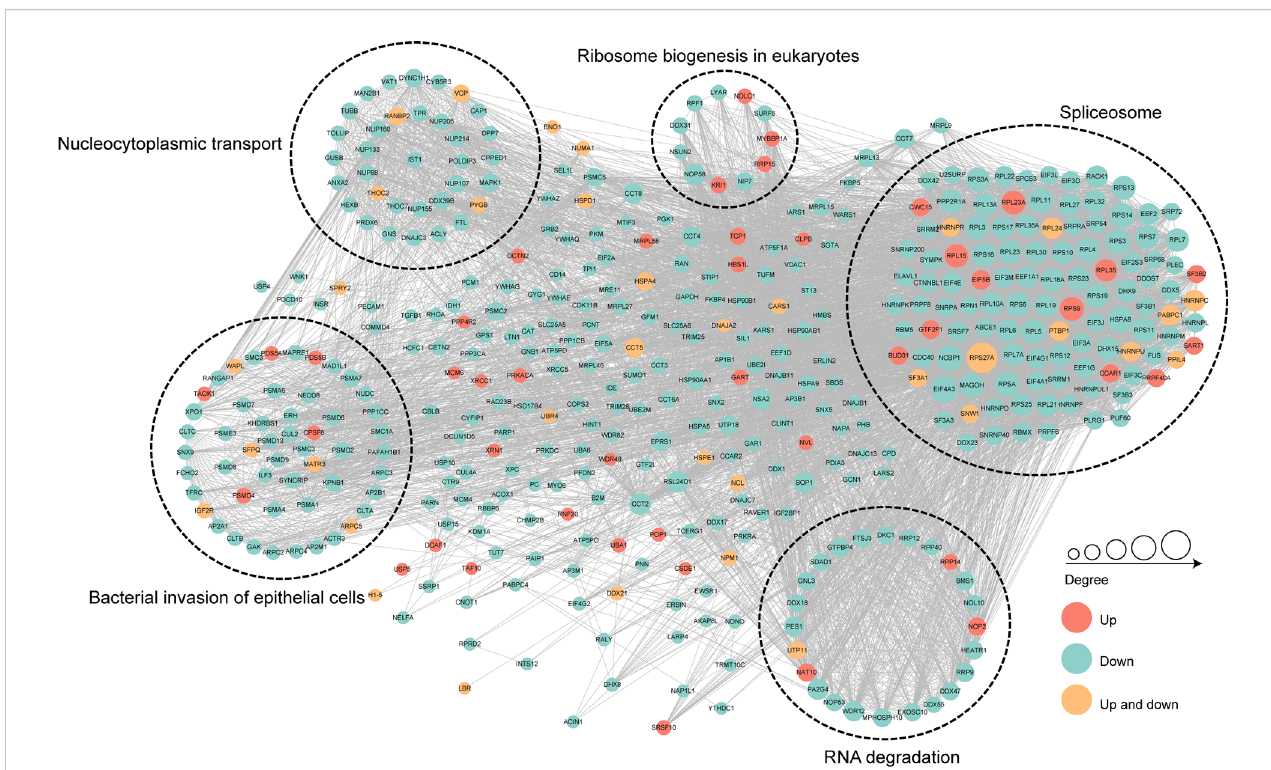
FIGURE 7 Protein-protein interaction network of the differentially crotonylated proteins. Protein-protein interaction network. Red nodes means up-regulated crotonylated proteins, blue nodes means down-regulated crotonylated proteins. Orange nodes means up and down regulated crotonylated proteins. The degree of nodes means the number of interacting proteins, the more protein nodes interacting with the protein, the node of this protein is